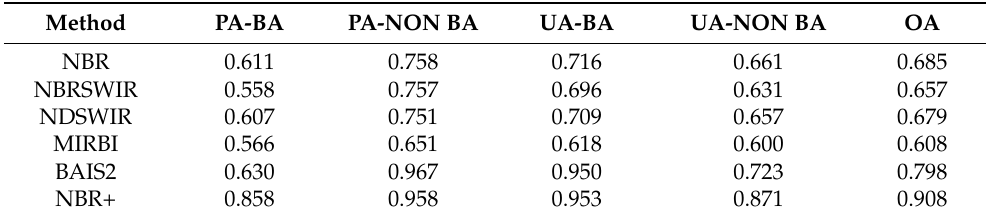
Table 2. Results of single-date thematic accuracy assessment on test sites including also water bodies and clouds (Group A).